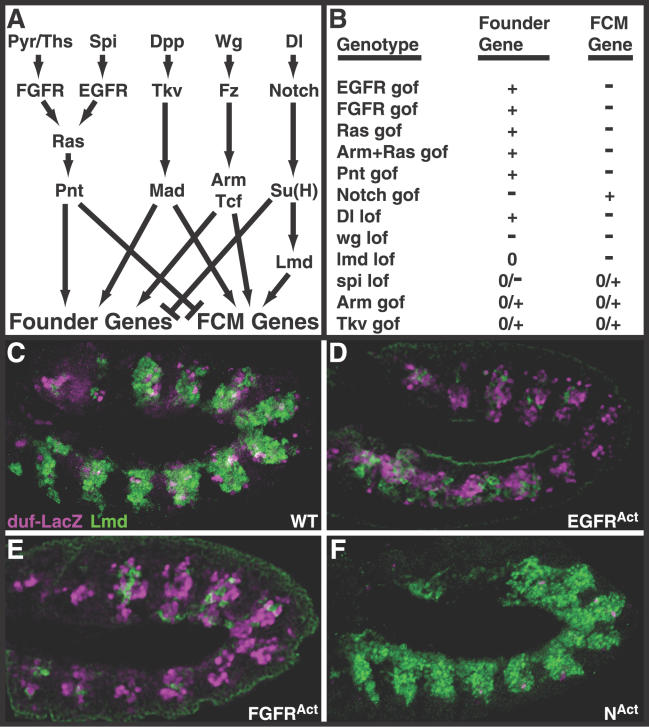
Differential Genetic Inputs to Two Classes of Somatic Myoblasts(A) A network of signaling molecules and transcription factors is known to positively and negatively regulate the specification of muscle FCs and FCMs.(B) Predicted behavior of genes specific to these cell types when key components of the network are genetically perturbed (+ indicates increased mesodermal expression relative to wild-type; −, decreased expression; 0, no change).(C–F) Expression of an FC marker (duf-lacZ, magenta) and an FCM marker (Lmd, green) show that in wild-type somatic mesoderm (C), FCs comprise a small number of individual cells, and the remainder of somatic myoblasts are FCMs. Constitutive activation of the EGF receptor (D) or FGF receptor (E) greatly expands the FC population at the expense of FCMs; remnant Lmd protein is excluded from nuclei. Conversely, constitutive activation of Notch signaling (F) largely eliminates the FC population with either no effect or perhaps a slight increase in FCMs apparent at the indicated resolution.